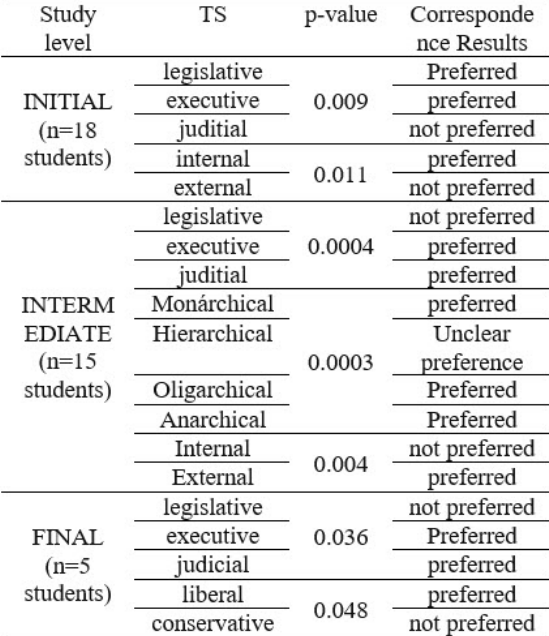
Table 3. Results of association and cor- respondence analysis.